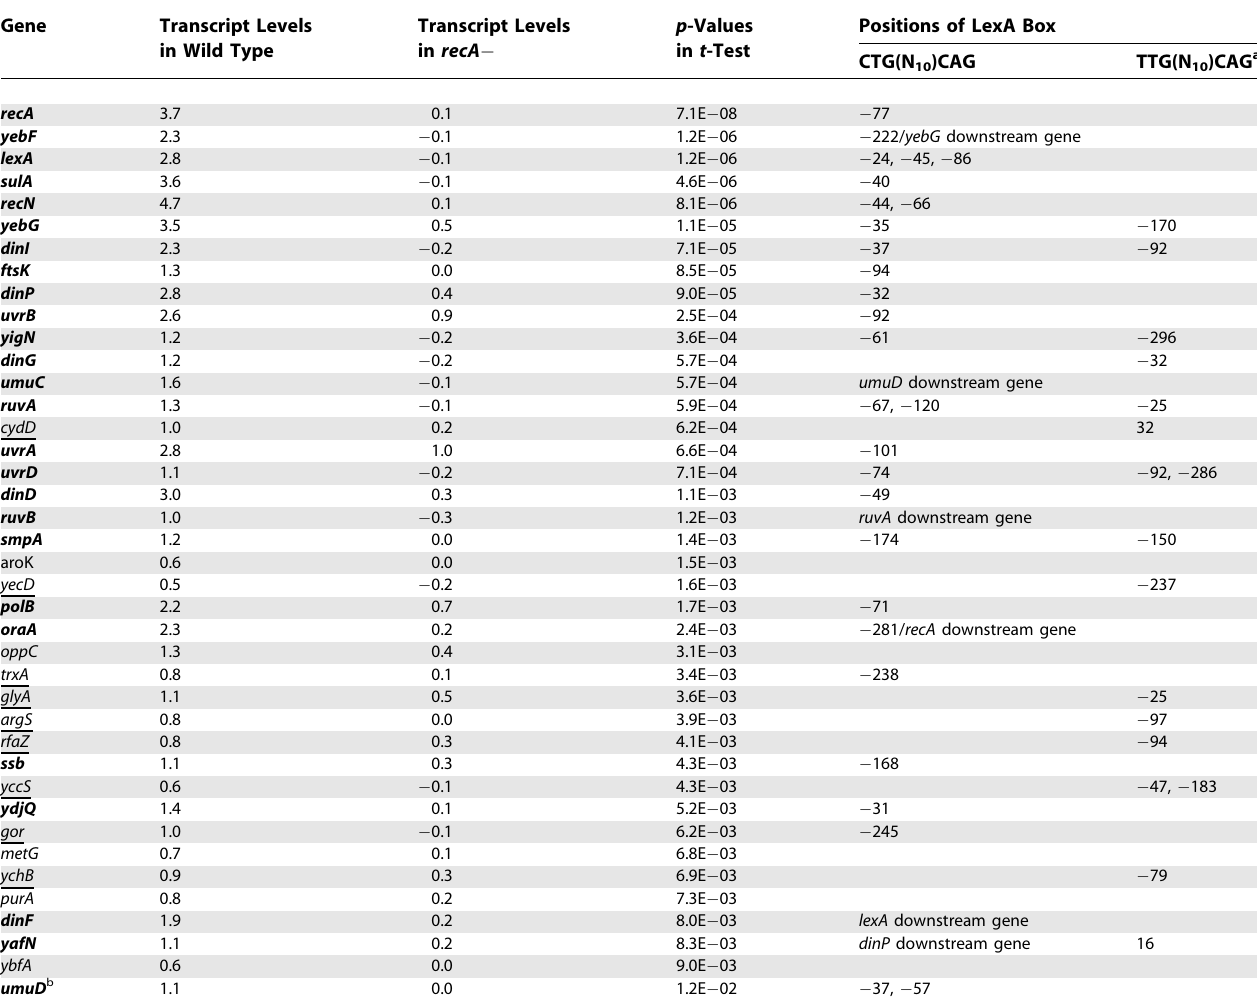
Table 1. RecA-Dependent Activation and Genes of the LexA Regulon Gene Transcript Levels in Wild Type